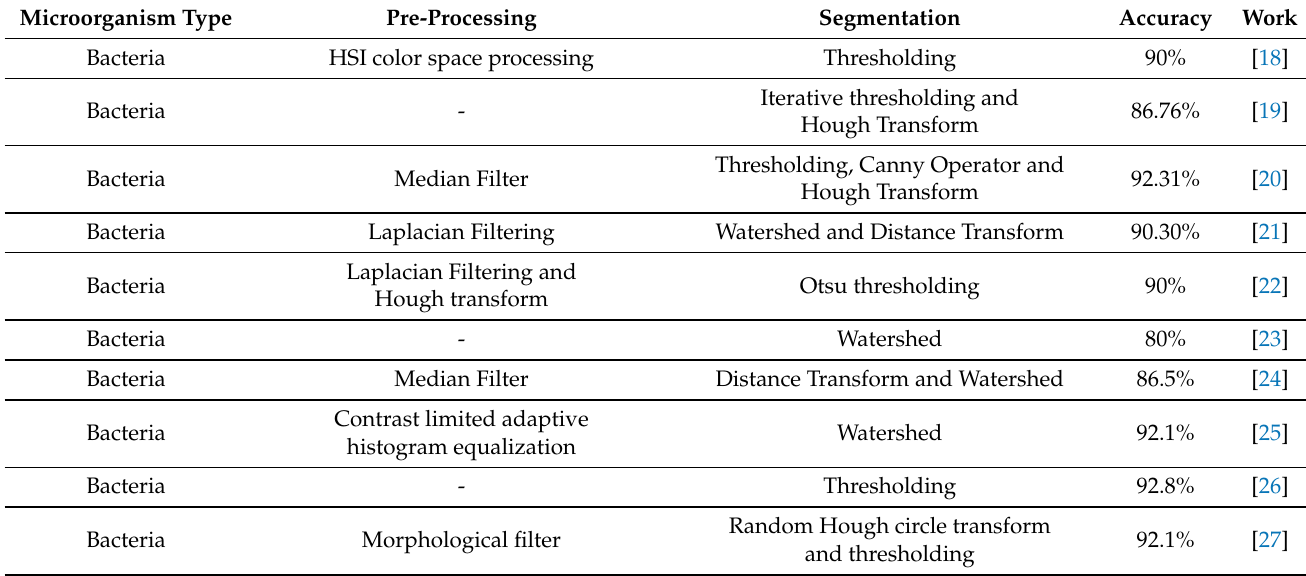
Table 1. State-of-the-art image analysis-based